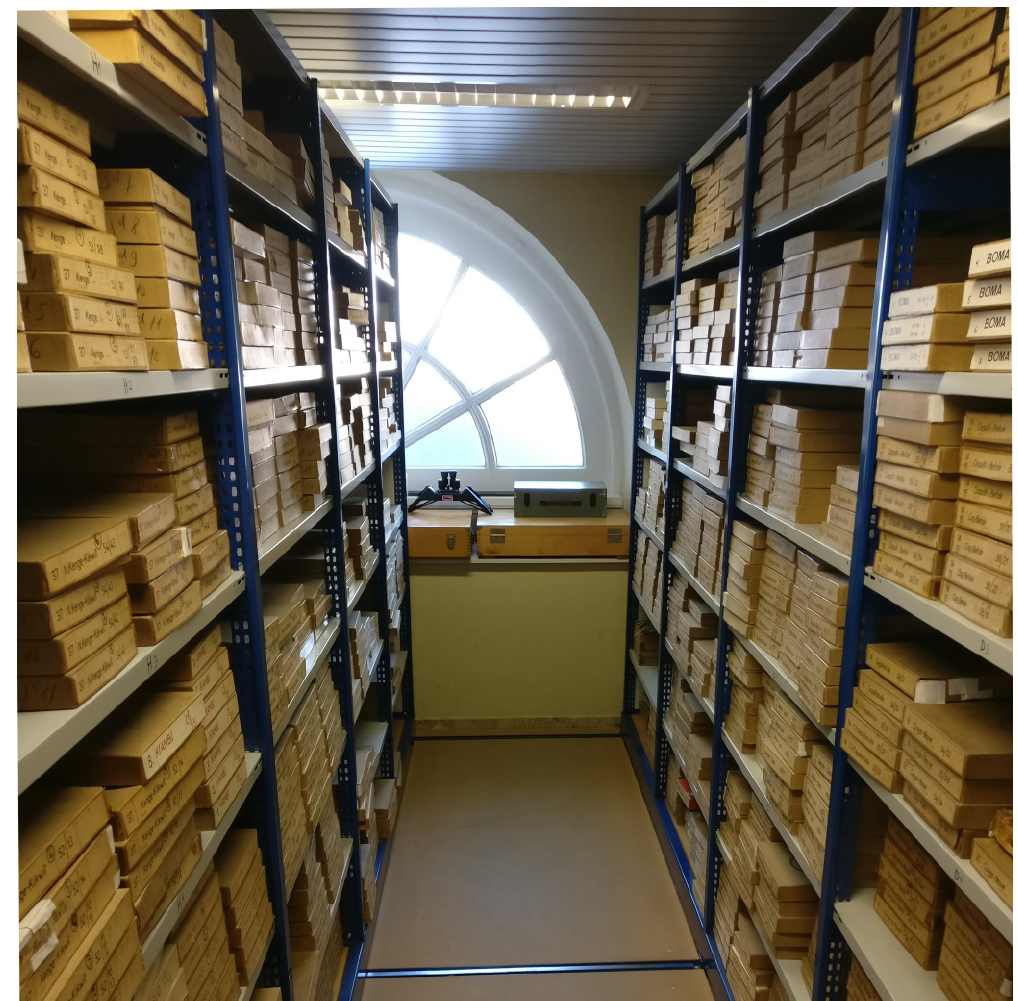
Figure A3. Shelves with aerial survey images at the Africa Museum archives, showing vasts amounts of historical data still mostly